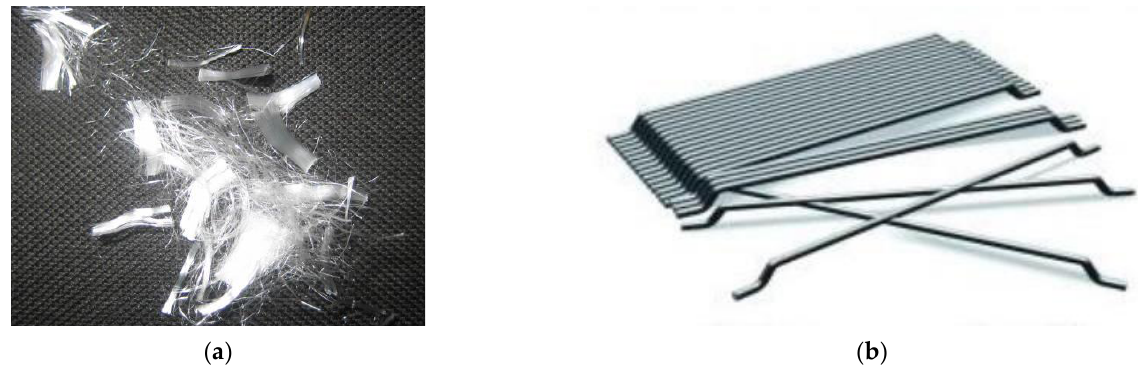
Figure 3. Common industrial fibers used in this paper: ( a ) polypropylene fibers; ( b ) steel fibers. Table 1. Basic characteristics of the industrial fibers used in this paper.